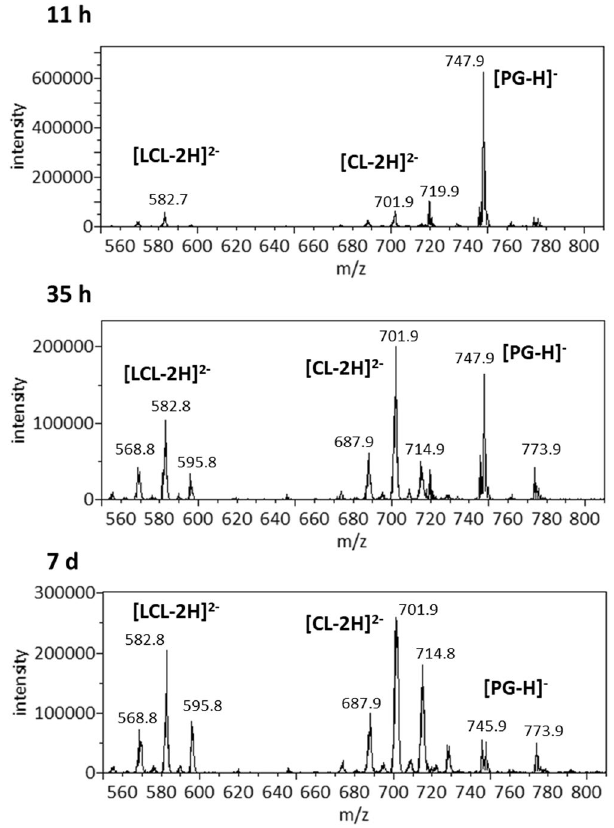
Figure 2. Precursor scans for m/z 153 anionic head group fragment. The most abundant peaks of phosphatidylglycerol (PG) anions ( m/z 747), CL double anions ( m/z 700–701) and lysocardiolipin (LCL) double anions ( m/z 582) are labeled. Top: Cells were grown for 11 h after inoculation. Middle: Cells were grown for 35 h. Bottom: Cells were grown for 7